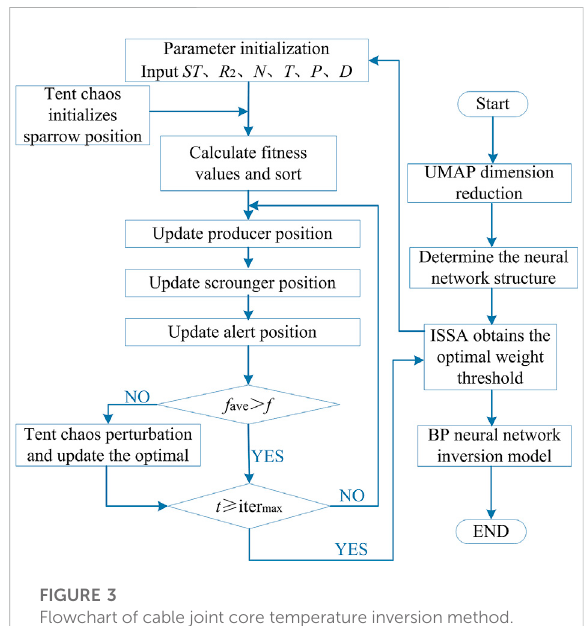
FIGURE 3 Flowchart of cable joint core temperature inversion